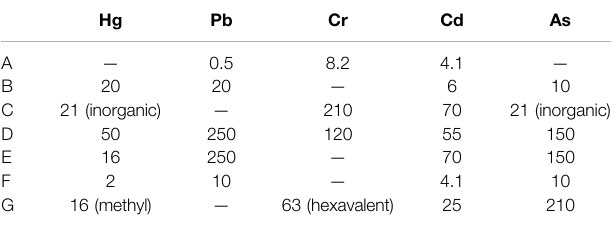
TABLE 2 | Daily consumption limits for the fi ve heavy metals ( μ g/day)